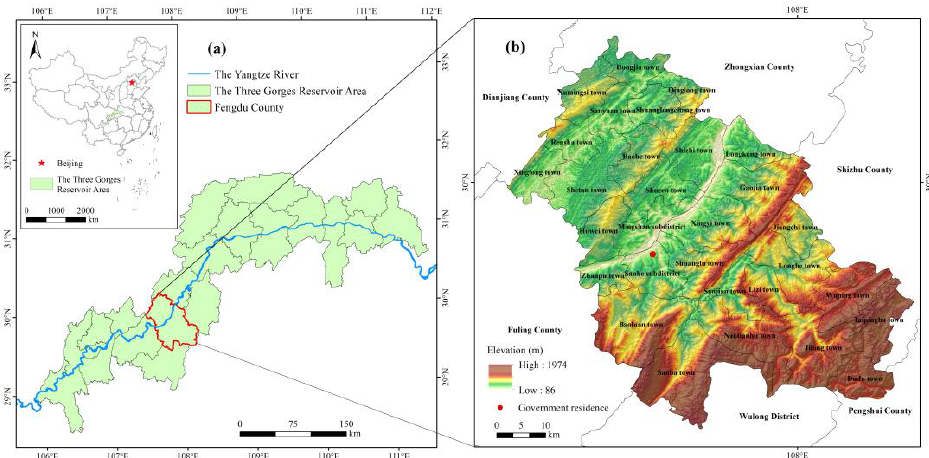
Figure 1. The study area: ( a ) the location of Fengdu County in the Three Gorges Reservoir Area; ( b ) the administrative divisions and elevation distribution of Fengdu County.